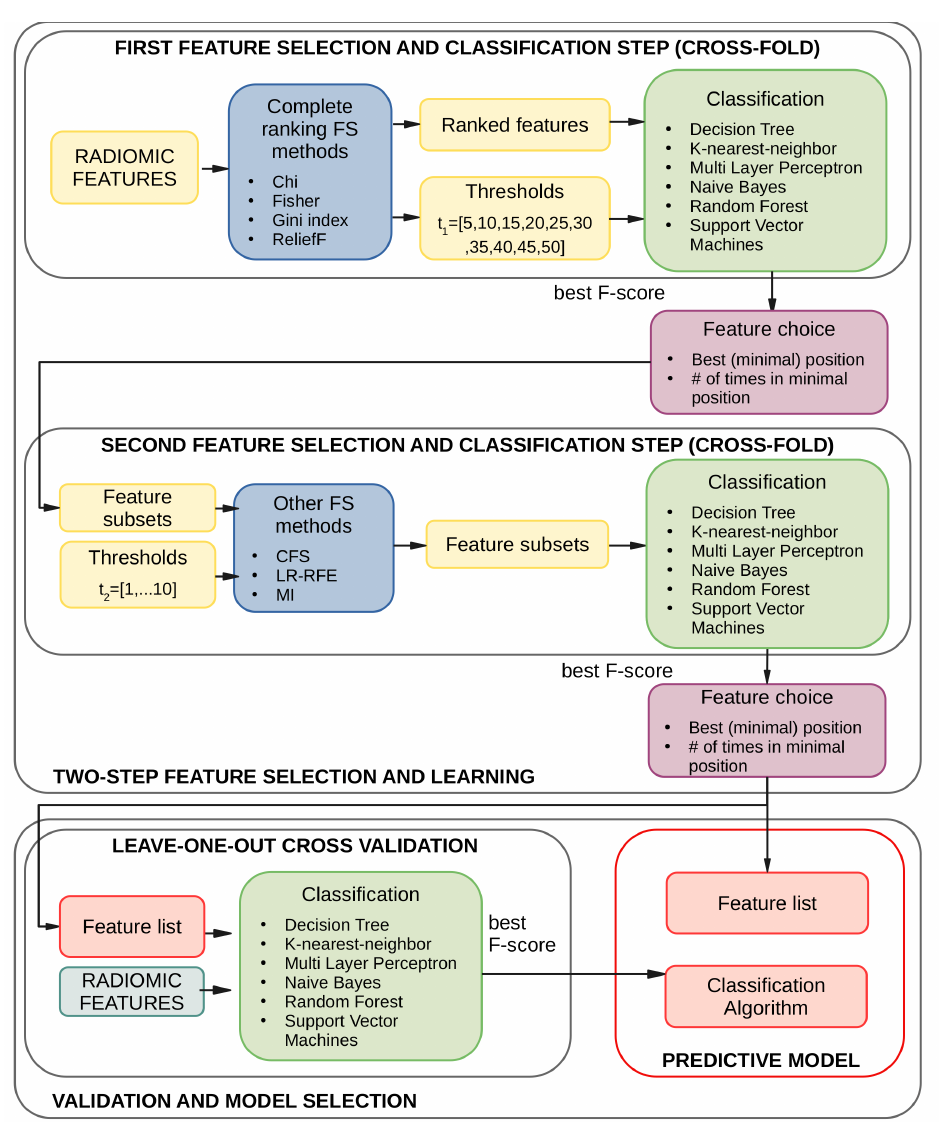
Figure 3. A schematic view of the ensemble feature selection and classification steps underlying the building process of each predictive model. The first two steps involve 10-fold cross-validation on the training dataset. The last step is based on a leave-one-out cross-validation (LOOCV) approach to validate the combination of selected features and classification models. The best F-score values drive the choice of the classification algorithm at each